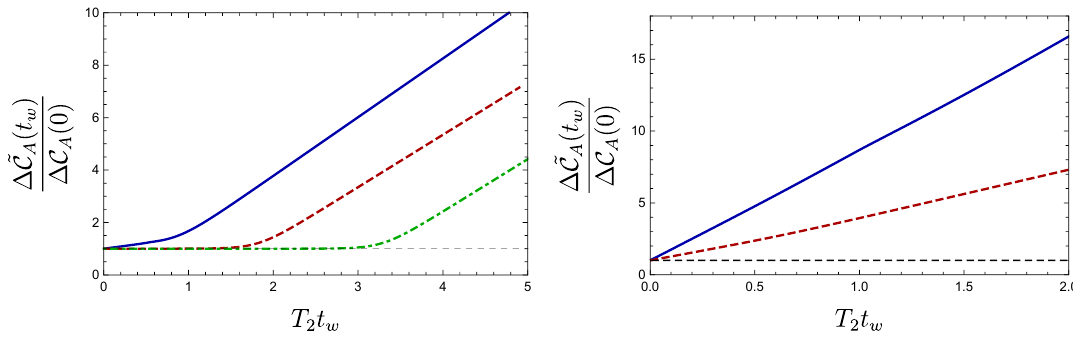
Figure 33. The complexity of formation for planar AdS 5 black hole as a function of the shock wave time t w , without the inclusion of the counterterm. We normalize by the complexity of formation of the unperturbed black hole in eq. (B.16). In the left panel, we show (cid:1) ~ ( t w ) for light shock waves C A with w = 1 + 10 (cid:0) 1 (solid blue), w = 1 + 10 (cid:0) 4 (dashed red) and w = 1 + 10 (cid:0) 8 (green dot-dashed). For very light shocks, the complexity of formation remains close to the unperturbed value until times of the order of t (cid:3) , then increases approximately linearly with t w . In the right panel, we scr show (cid:1) ~ ( t w ) for heavier shock waves, with w = 2 (solid blue) and w = 1 : 5 (dashed red). The C A overall behaviour is similar to the complexity of formation in (cid:12)gure 30, with the inclusion of the counterterm. Therefore, it contrasts with the BTZ black hole results in section